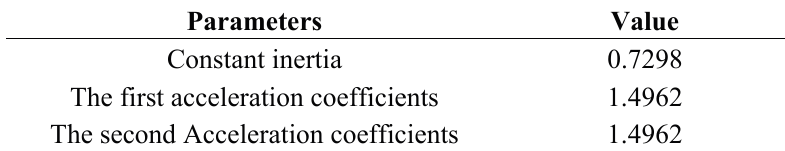
Table 6. The parameters setting of particle swarm optimization (PSO).